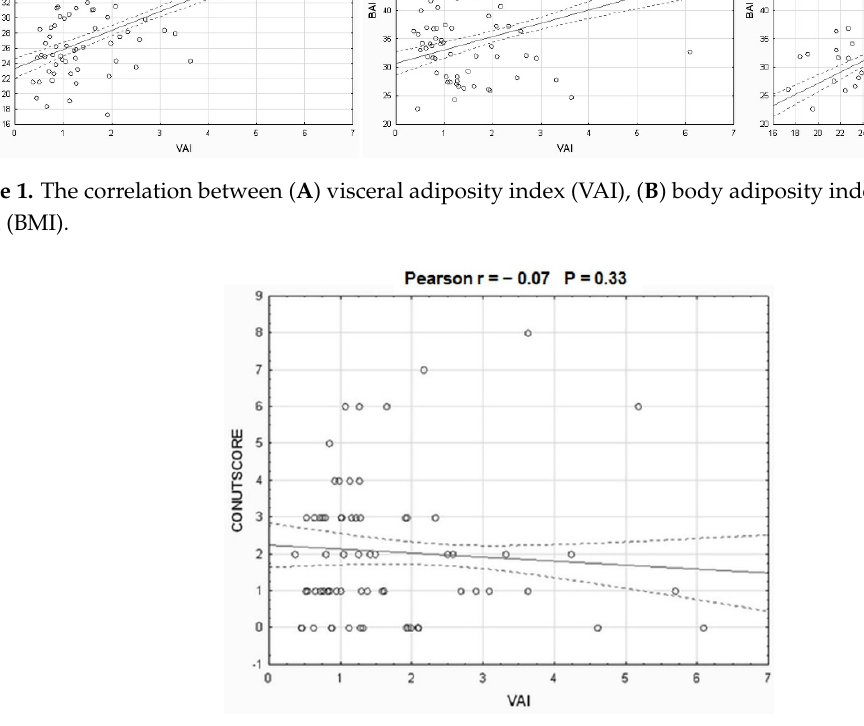
Figure 2. The correlation between visceral adiposity index (VAI) and body-mass index CONUT score.